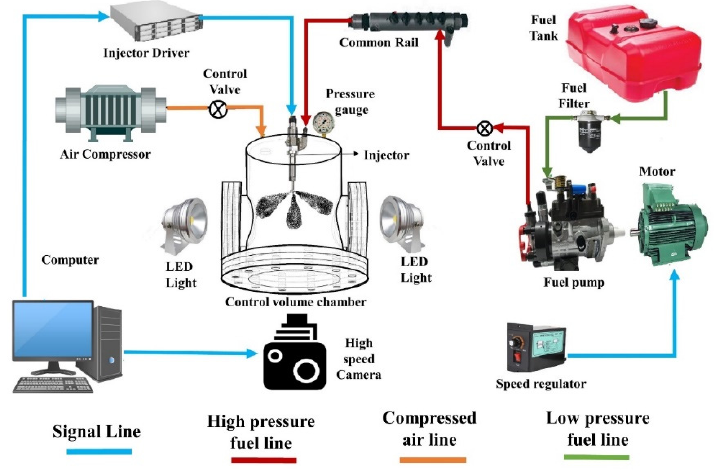
Figure 5. Schematic of experimental setup showing the high-pressure control volume vessel (CVV) for fuel spray visualization.